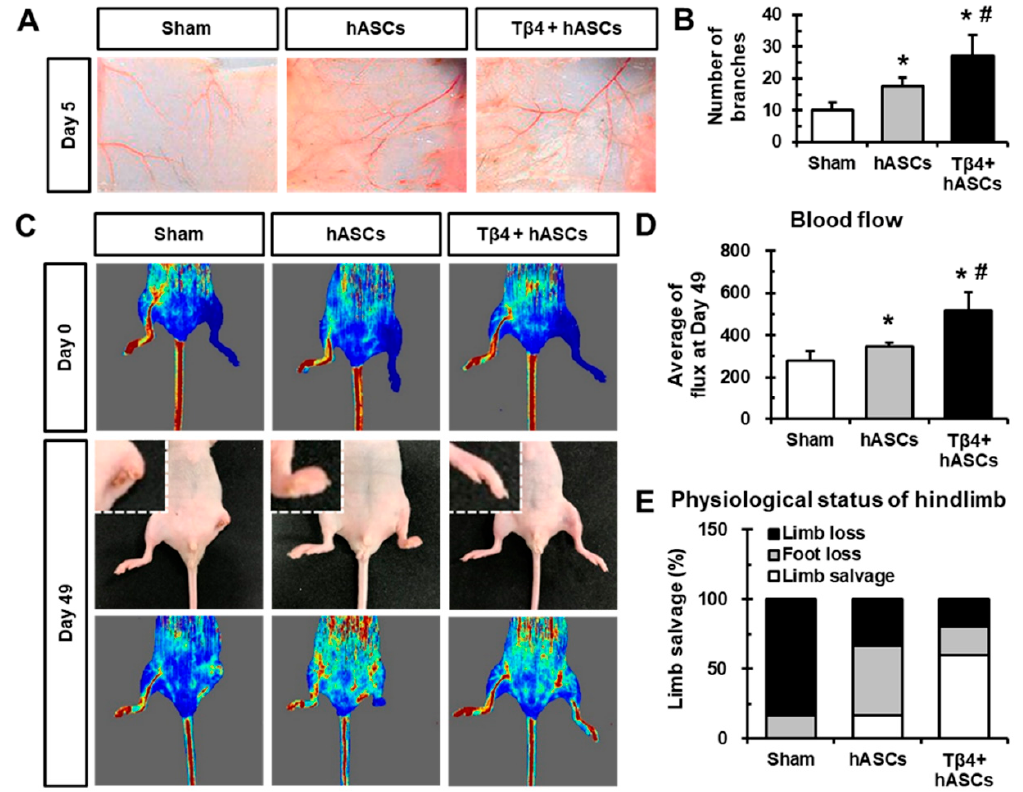
Figure 4. Transplantation of hASCs in combination with T β 4 improves blood vessel recruitment and blood flow after ischemia. ( A ) Representative images of mouse dorsal window chamber model after 5 days of transplantation of chambers containing hASCs without or with T β 4. ( B ) Quantification of the number of microvessel branches per chamber depending upon the transplantation condition. * p < 0.05 vs. Sham; # p < 0.05 vs. hASCs. n = 3 rats in each group. ( C ) Representative Laser Doppler images after induction of hindlimb ischemia (day 0) and after 49 days of transplantation. Magnified inlet images show limb loss in the sham group and foot loss in the hASCs group. Sham ( n = 6); hASCs ( n = 5); T β 4 + hASCs ( n = 6). ( D ) Measurement of blood flow at day 49, as measured by Laser Doppler images. * p < 0.05 vs. Sham; # p < 0.05 vs. hASCs. ( E ) Percentage of physiological status of hindlimb after 49 days of ischemia and transplantation. * p < 0.05 vs. Sham; # p < 0.05 vs.